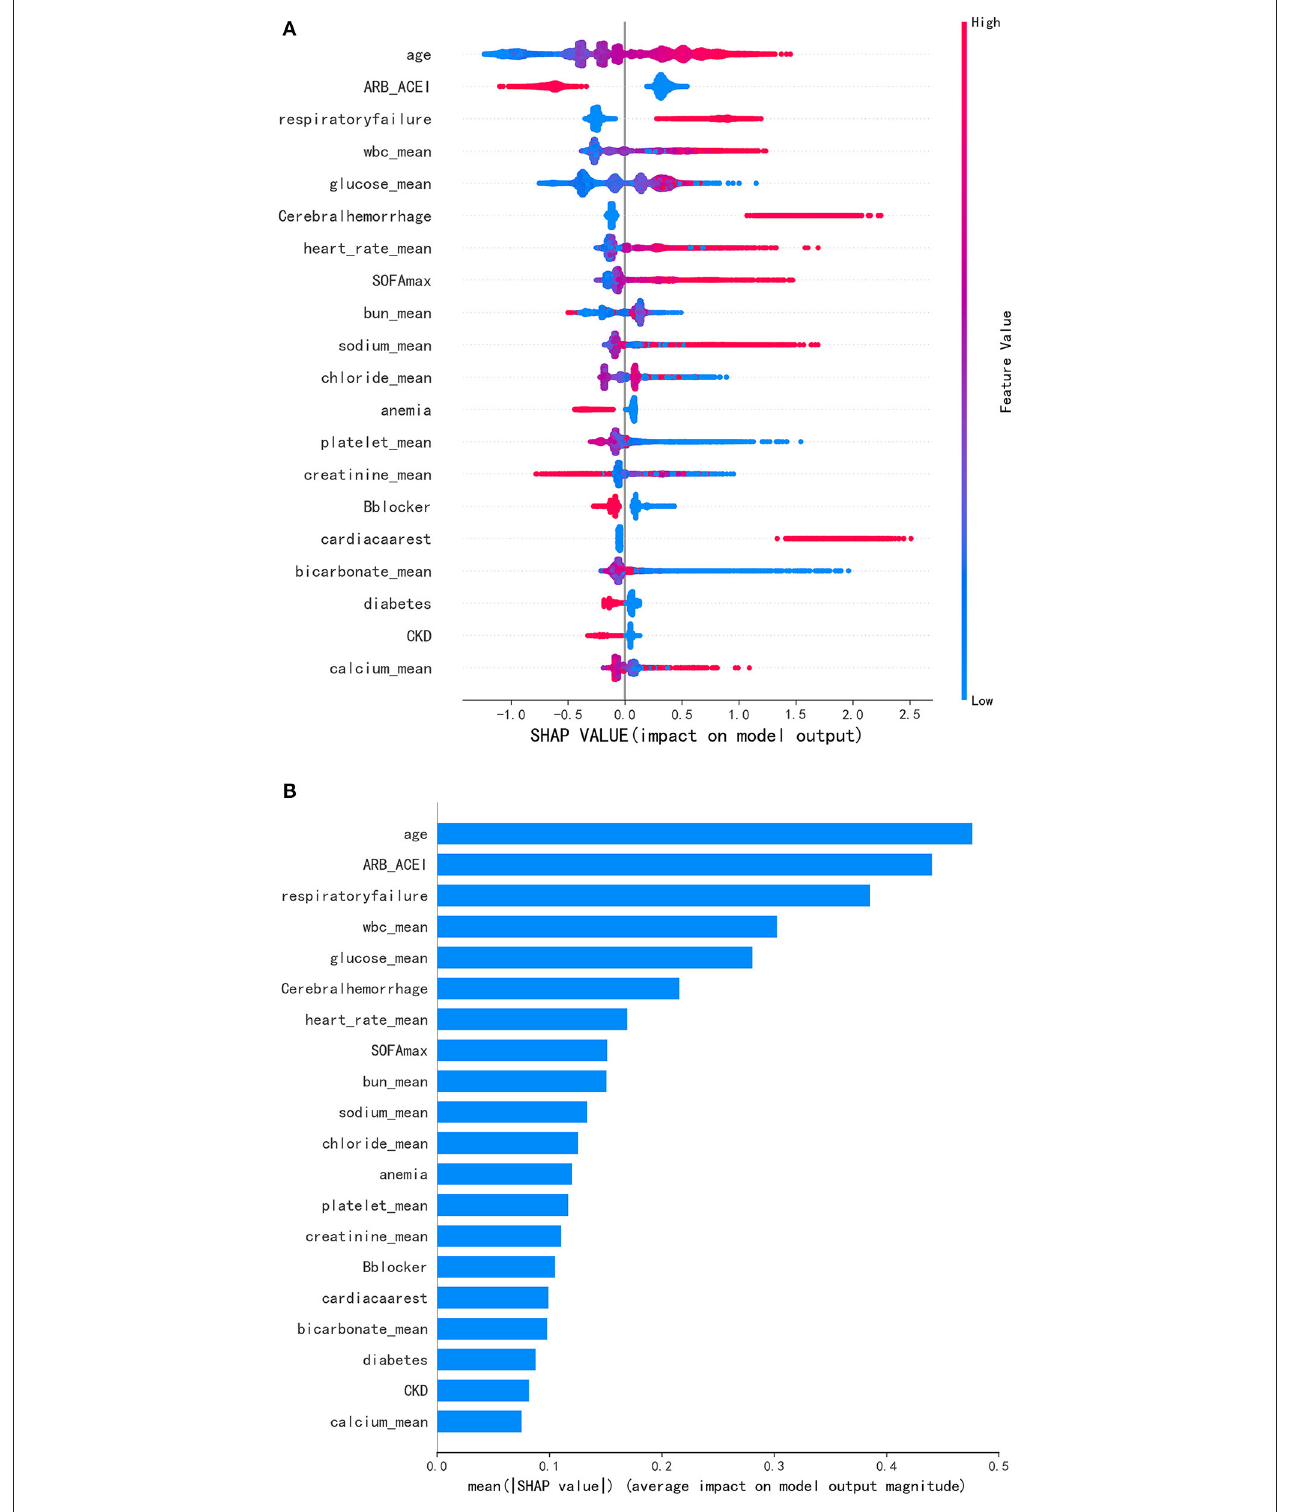
FIGURE 4 | (A) Distribution of the impact each feature had on the full model output using SHapley Additive exPlanations (SHAP) values. (B) Significance of the predictors in the LightGBM model. Features were ranked according to the sum of absolute SHAP values of all samples. Longer bars indicated greater feature importance. Blue represented the lower value and red represented higher value of a single sample. A positive SHAP value represented an increase in the risk of hospital mortality.